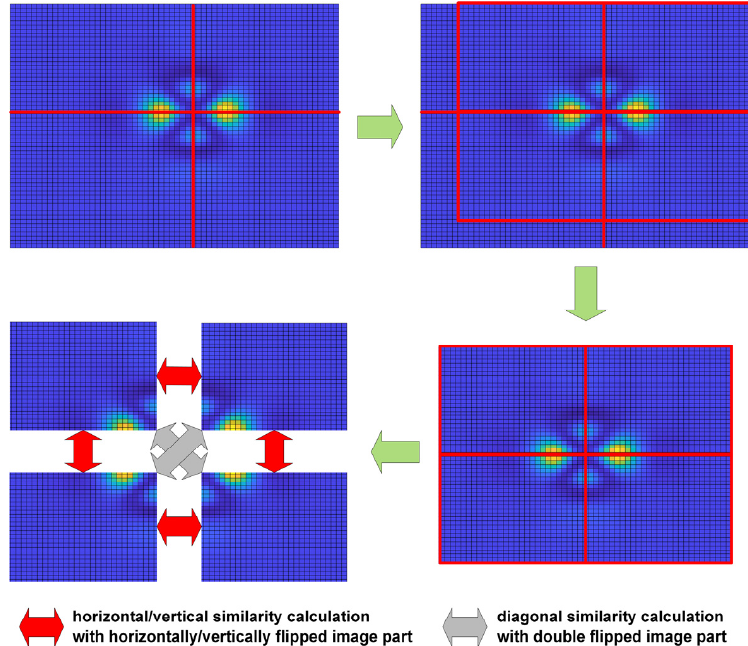
Figure 17. Illustration of the idea of mutual similarity calculation for the symmetrical fragments of the sample image.